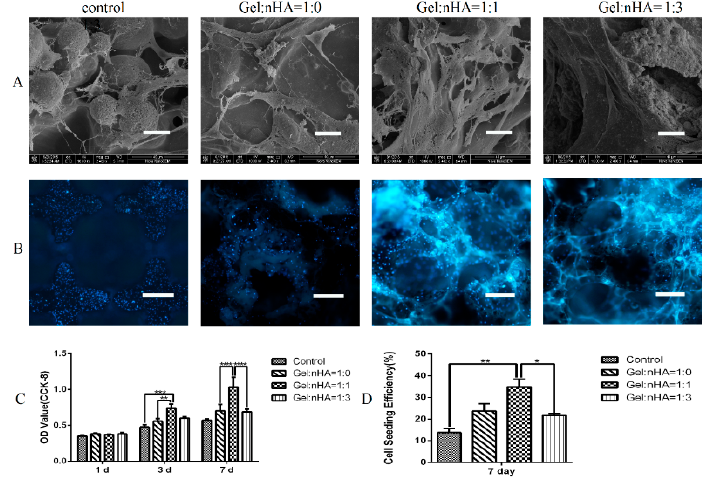
Figure 3. Cell attachment and proliferation on hybrid scaffolds. ( A ) morphology of cells attached on different scaffolds; ( B ) cell seeding efficiency based on DAPI staining of cells attached on different scaffolds (100×); ( C ) cell proliferation measured based on optical density (OD )value by CCK-8 assay; ( D ) cell seeding efficiency calculated by ImageJ software (NIH, Bethesda, MD, USA). Scale bar: 20 μ m ( A ), 500 μ m ( B ). * p < 0.05, ** p < 0.01, *** p < 0.001, **** p < 0.0001.